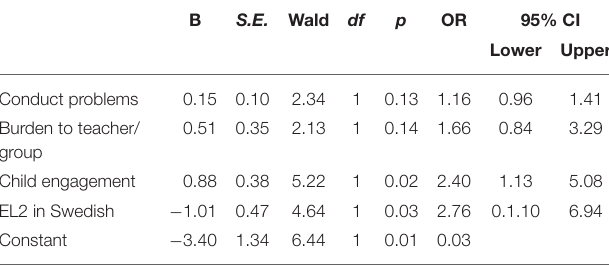
TABLE 5 | Logistic regression model assessing the probability of receiving SiS.